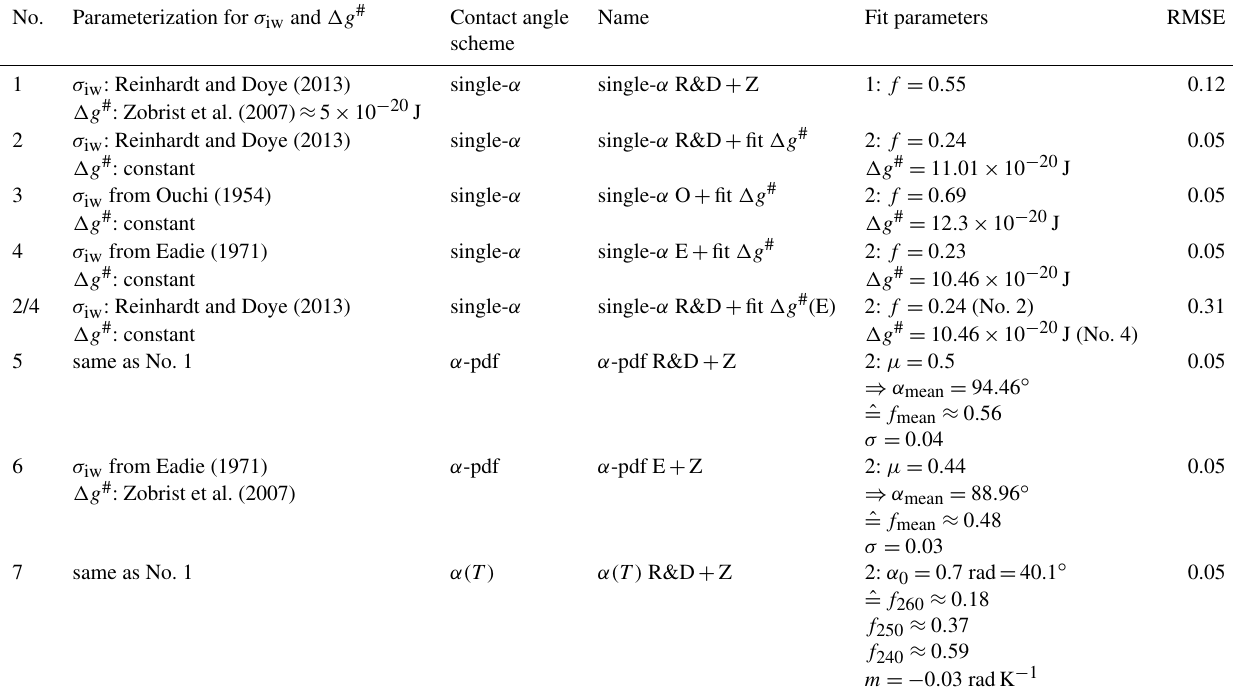
Table 1. Overview of CNT formulations used for the sensitivity analysis, results for the fit parameters, and evaluation of the fit result. The values are rounded to two digits after the decimal point. The logarithmic mean contact angle µ and the temperature-dependent contact angles are converted into the corresponding geometric term f using Eq. (3). CNT formulation nos. 1, 5, and 7 use the best fitting combination of σ iw and (cid:49)g # emerging from the homogeneous freezing analysis in Ickes et al.